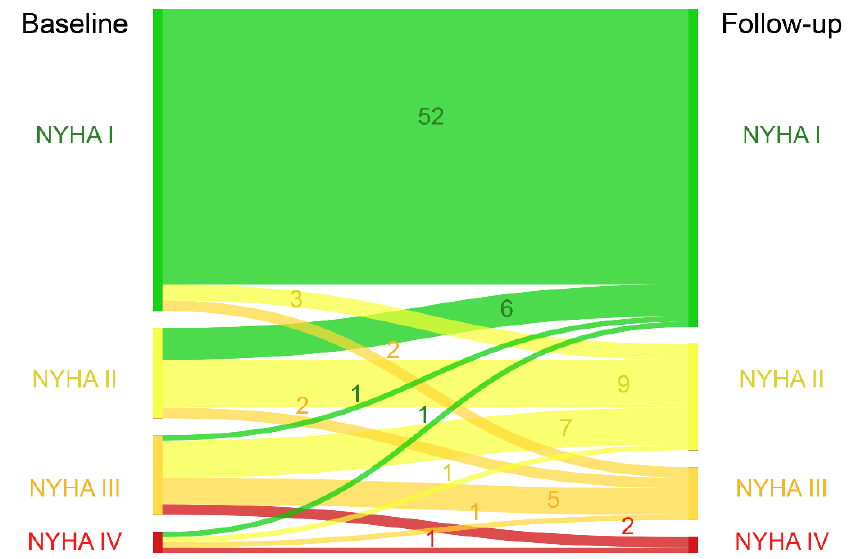
Figure 1. Sankey diagram of New York Heart Association class at baseline and follow-up. While 34% had a reduced SRV function at baseline, this number increased to 46% at the last follow-up (Figure 2).